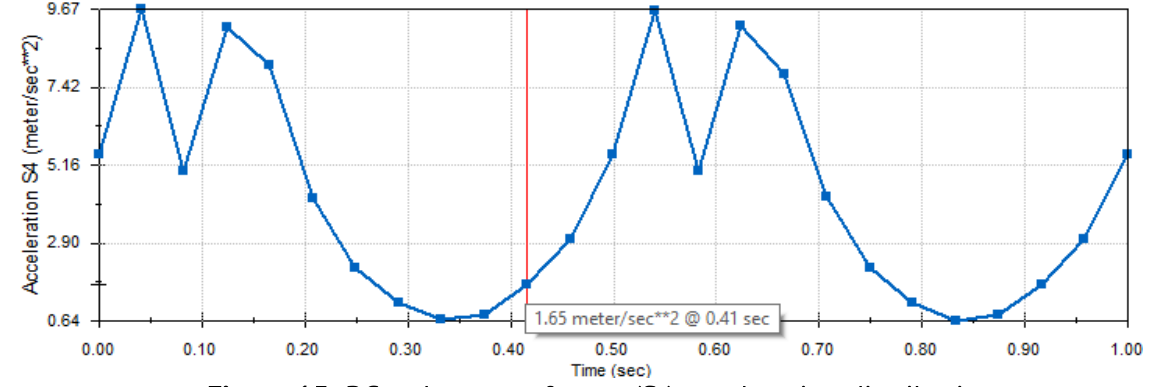
) acceleration distribution. 4